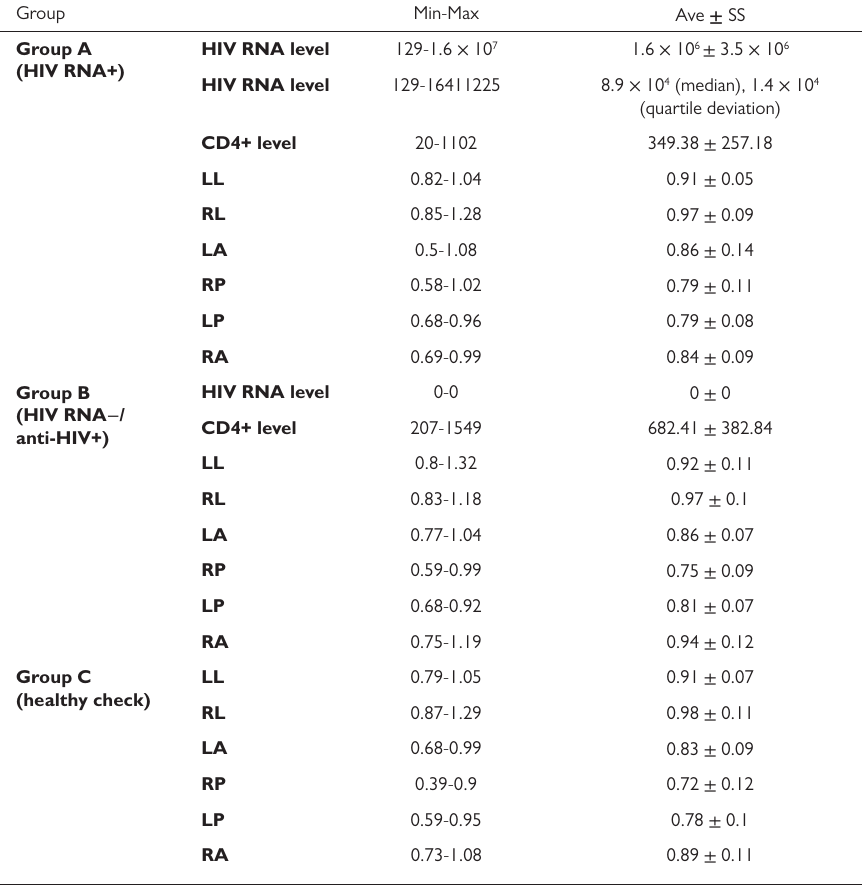
Table 2. The Minimum, Maximum, Average, and Standard Deviation Values of the Research Parameters Group Min-Max Group A (HIV RNA+)